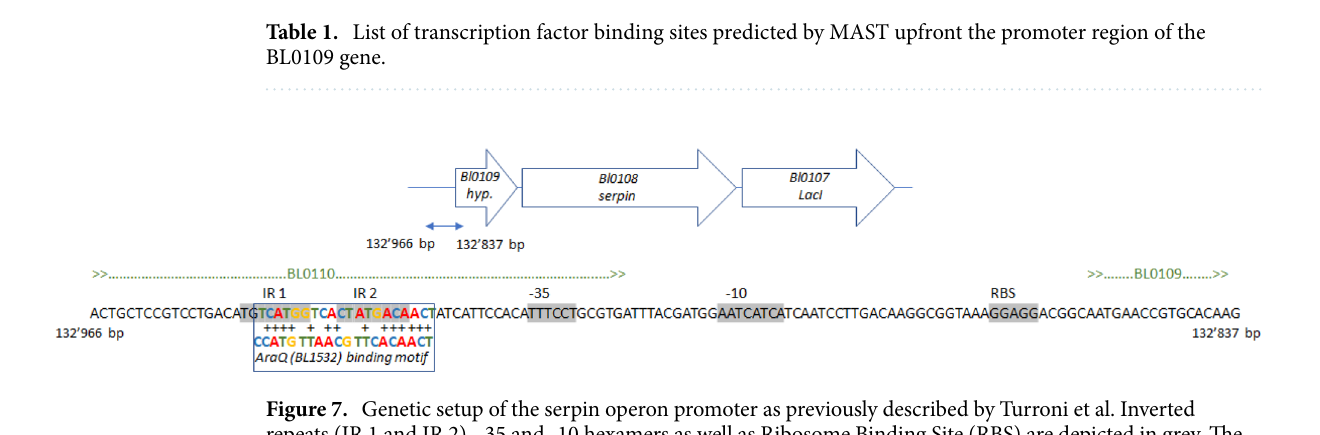
Figure 7. Genetic setup of the serpin operon promoter as previously described by Turroni et al. Inverted repeats (IR 1 and IR 2), -35 and -10 hexamers as well as Ribosome Binding Site (RBS) are depicted in grey. The motif identified using MAST and resembling the previously predicted AraQ motif ahead of the BL1532 gene is depicted with bold